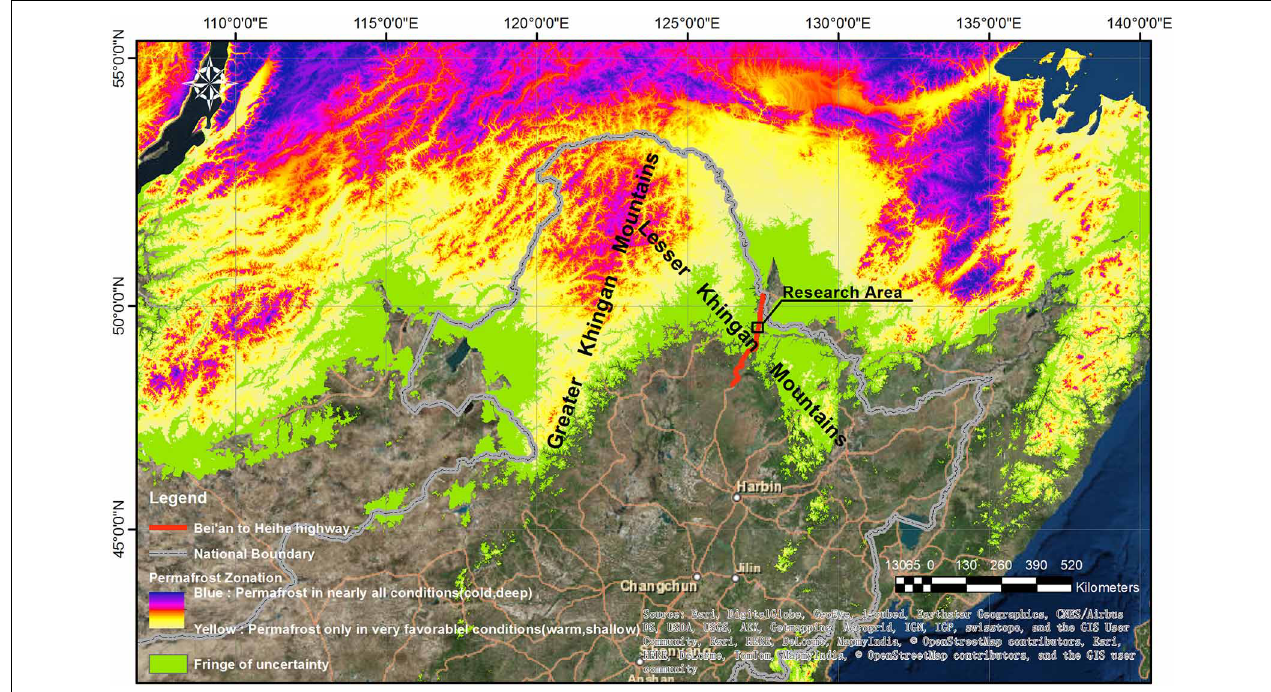
FIGURE 1 | High-latitude permafrost distribution in Northeast China (data from Zurich University, Switzerland), and the location of study area.